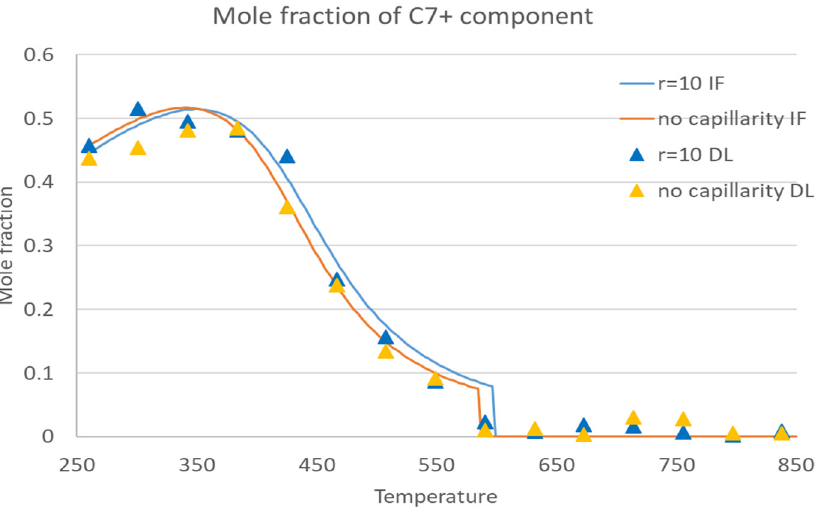
Figure 8. Mole fractions of C7+ component in the liquid phase changing with temperature under the constant overall mole concentration as 189.85 mol/m 3.